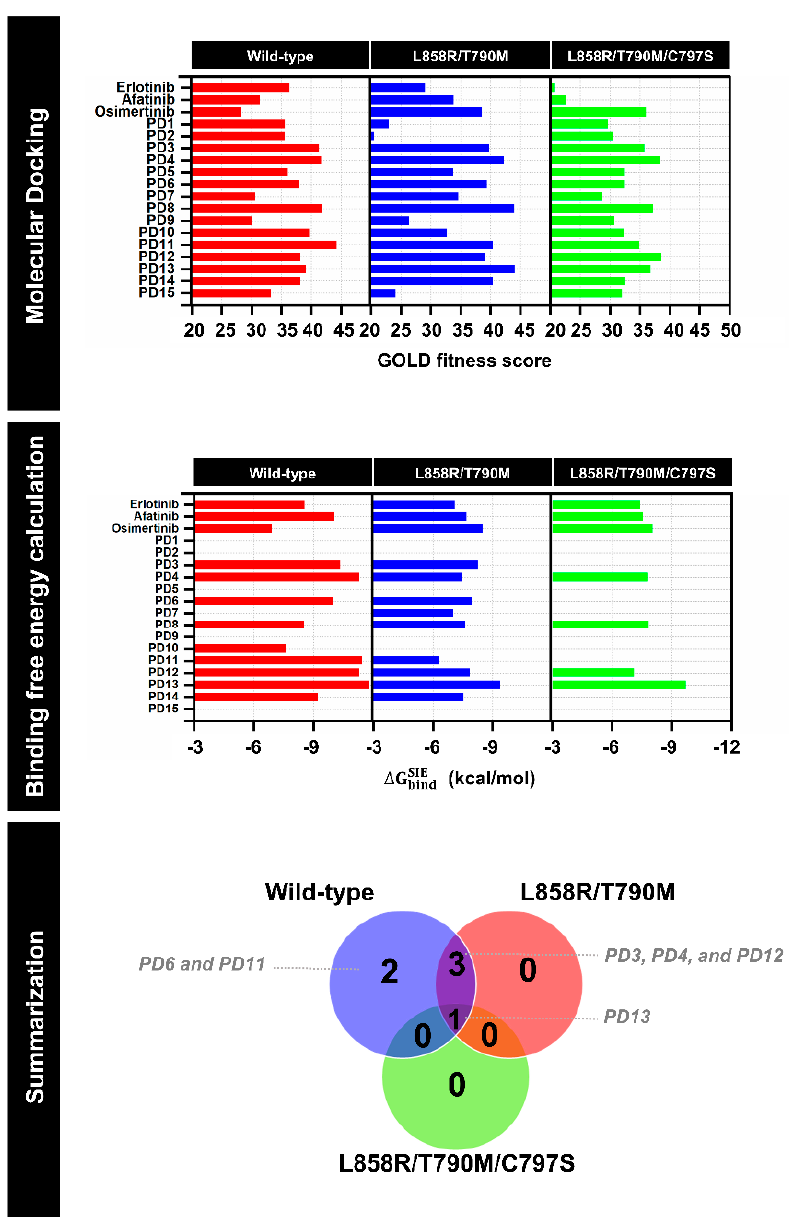
Figure 2. Docking results ( top ), estimated binding free energy calculation based on SIE method ( middle ), and summarization of virtual screening ( bottom ) of furopyridine ( PD ) derivatives towards wild-type, L858R/T790M, L858R/T790M/C797S EGFR relative to three reference drugs (erlotinib, afatinib, and osimertinib).